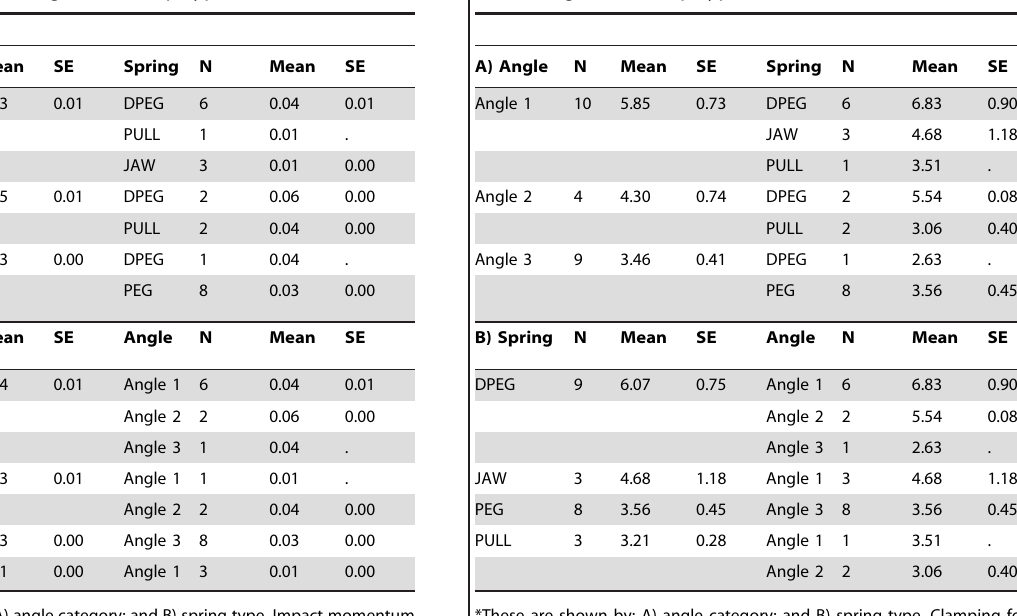
Table 4. Mean values and standard errors of impact momentum (Ns) among mouse trap types*.